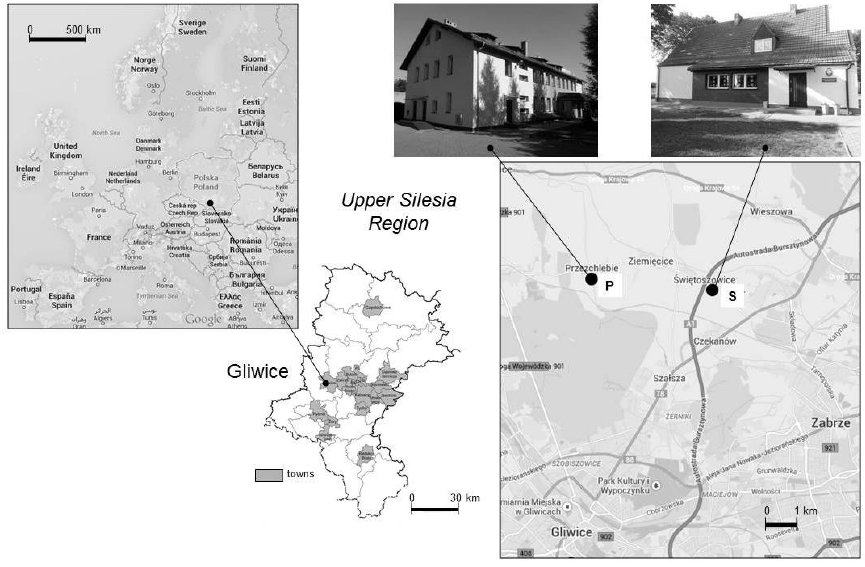
Figure 1. Location of the investigated nursery schools (Map data: 2015© Google, ORION-ME). Table 1. Summary of the occupancy and IAQ parameter characteristics for each studied classroom, as well as for the outdoor air.